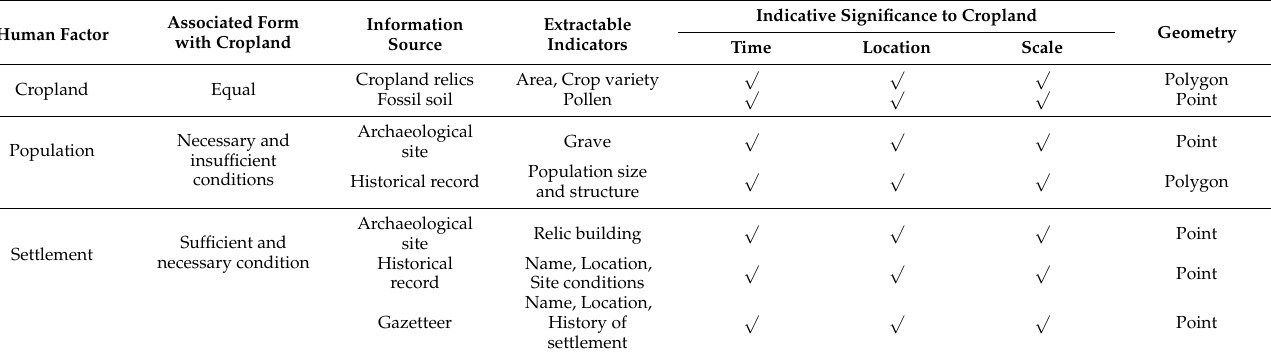
Table 1. Examples of human factors and their usability for indicating the distribution of histori- cal